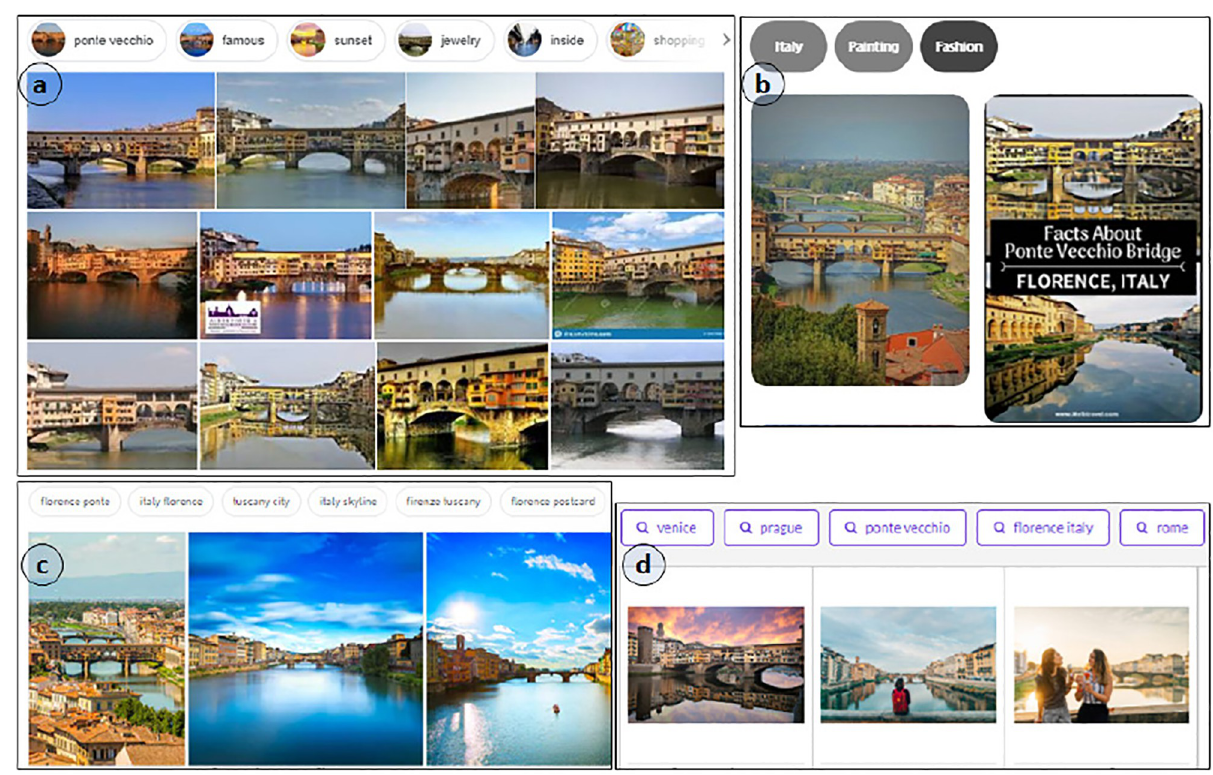
Fig 1. Presentation of image results over web search engines in semantically relevant